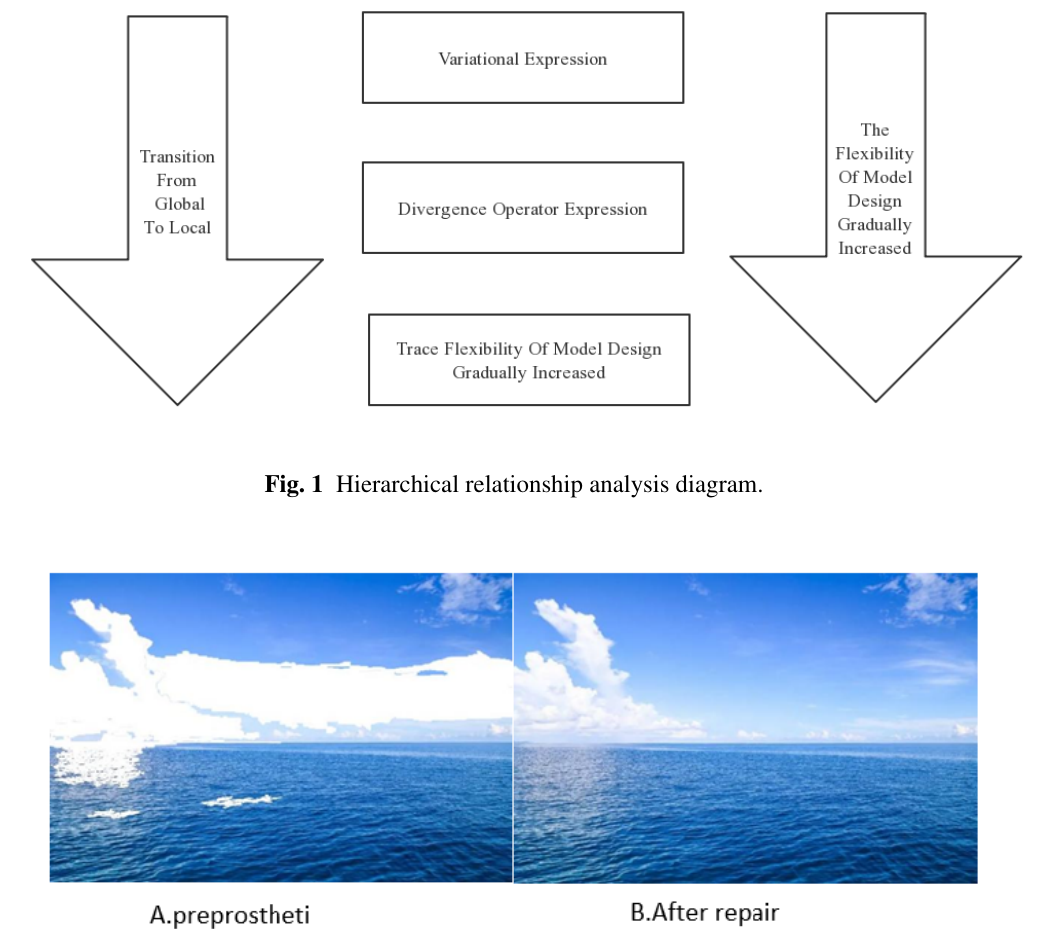
Fig. 2 Repair effect of